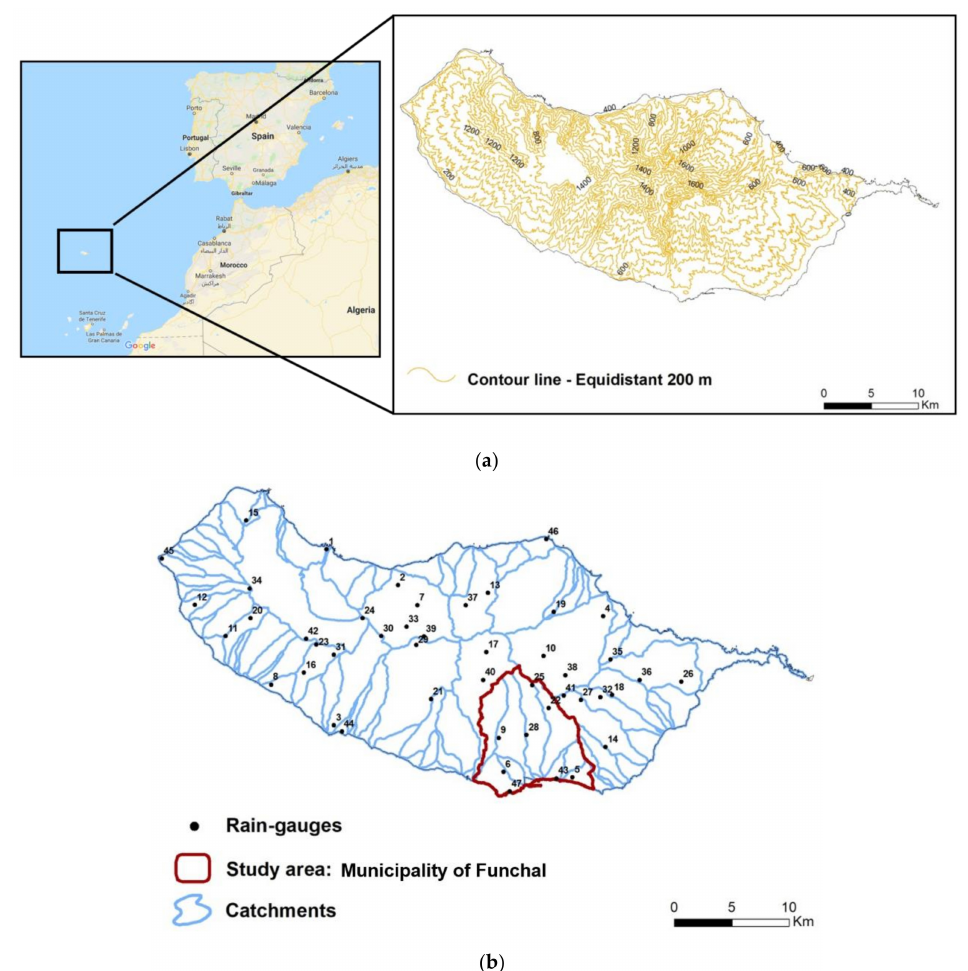
Figure 1. Location and relief ( a ) of the island of Madeira (Portugal), and ( b ) location of the 47 rain-gauges considered in this